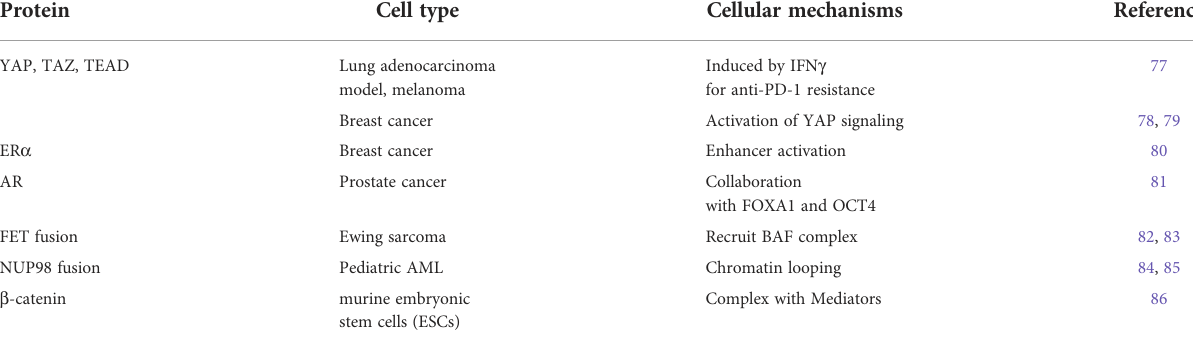
TABLE 1 Summary of transcription factors and epigenetic factors activated by LLPS.